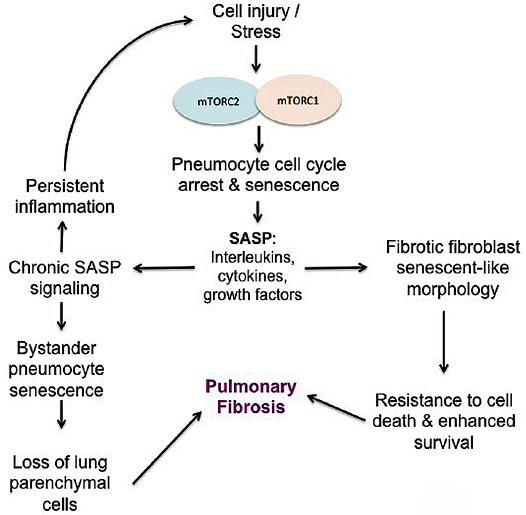
Figure 10. Proposed interaction between mTOR and the induction of SASP signals. Senescent pneumocytes may contribute to pro-inflammatory and pro-fibrotic signals, which further contribute to the development of pulmonary fibrosis through the loss of parenchymal cells and selection for improved fibroblast survival.